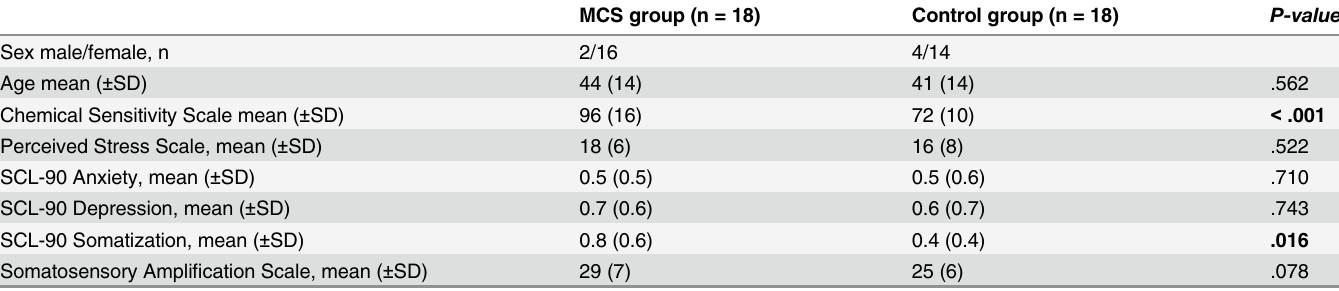
Table 1. Characteristics of the multiple chemical sensitivity (MCS) and the control group. Symptom Checklist (SCL).